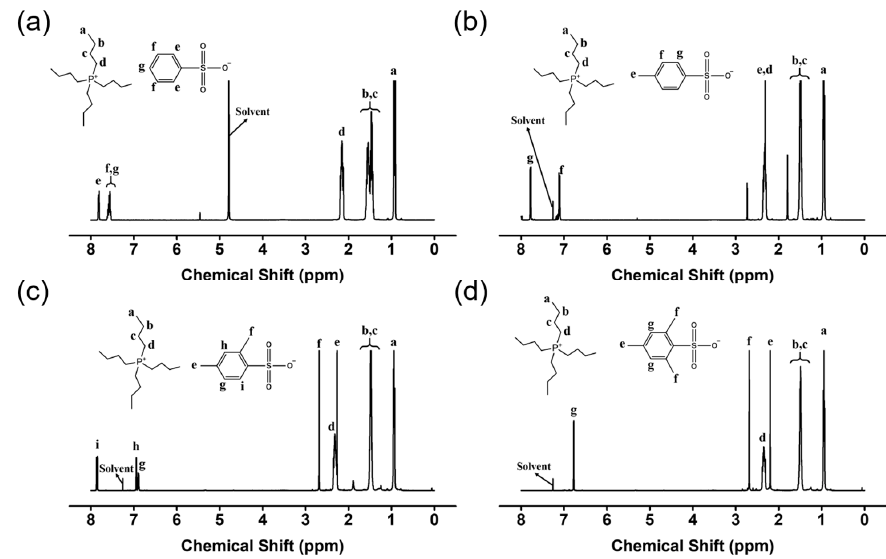
Figure 2. Proton nuclear magnetic resonance ( 1 H − NMR) spectrum of ( a ) [TBP][BS], ( b ) [TBP][MBS], ( c ) [TBP][DMBS], and ( d ) [TBP][TMBS].